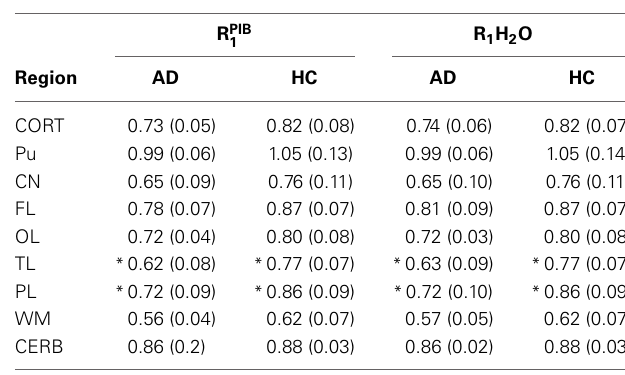
Table 4 | Regional R 1 measures relative to the cerebellar gray matter reference.